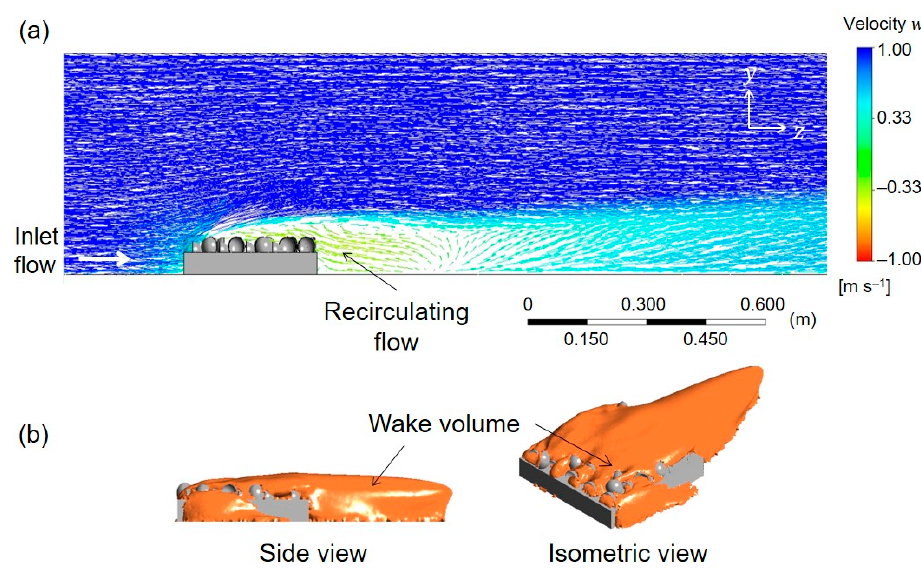
Figure 6. Illustration of the wake region of an AOR model (the number of shells N = 50): ( a ) velocity vectors showing recirculating flow and ( b ) views of the wake volume (orange color).